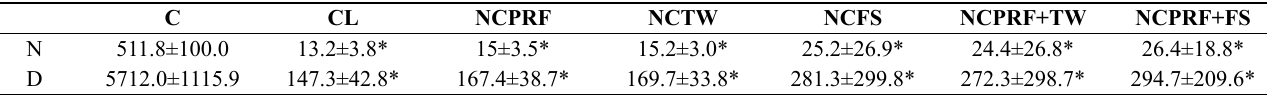
Table 2. Histomorphometric evaluation of median nerves, for the different groups, in the variables: total number of morphologically intact axons (N) and axonal density (D) considering the area of 0.0896 mm 2 . The groups (absolute control (C), control lesion (CL), Nerve compression and PRF (NCPRF), Nerve compression and treadmill walking (NCTW), Nerve compression and free swimming (NCFS), Nerve compression, PRF and treadmill walking (NCPRF+TW) and Nerve compression, PRF and free swimming (NCPRF+FS) are presented in columns. C CL 511.8±100.0